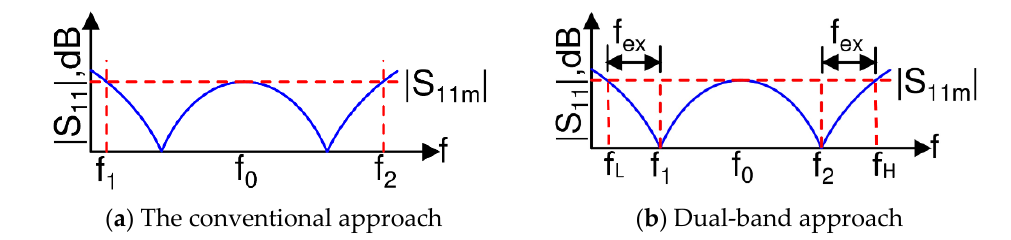
Figure 1. The conventional vs the proposed design methodologies.